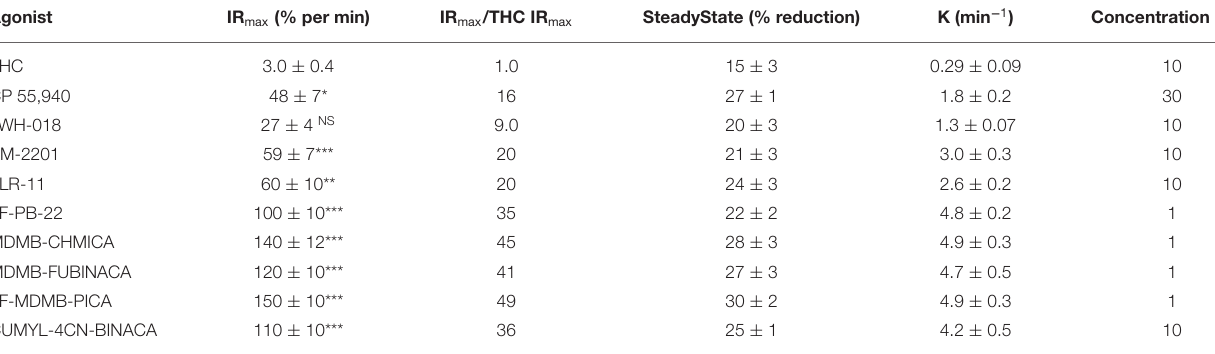
The IR max was quantified for reduction of membrane potential stimulated by a maximally-effective concentration of the agonist. Also shown are the SteadyState and K rate constant values from the curve fitting to the time course data, used to calculate the IR max using the equation, Initial rate = SteadyState × K. The SteadyState value was corrected for the injection artifact which resulted in a slight, immediate drop of the signal (see Materials and Methods). Values are mean ± SEM from 5 to 9 independent experiments. Differences of IR max between test compounds and THC were tested statistically by single-factor ANOVA followed by the Dunnett multiple comparison test, comparing each compound with THC ( * P < 0.05; ** P < 0.01; *** P < 0.001; NS, not significant, P >